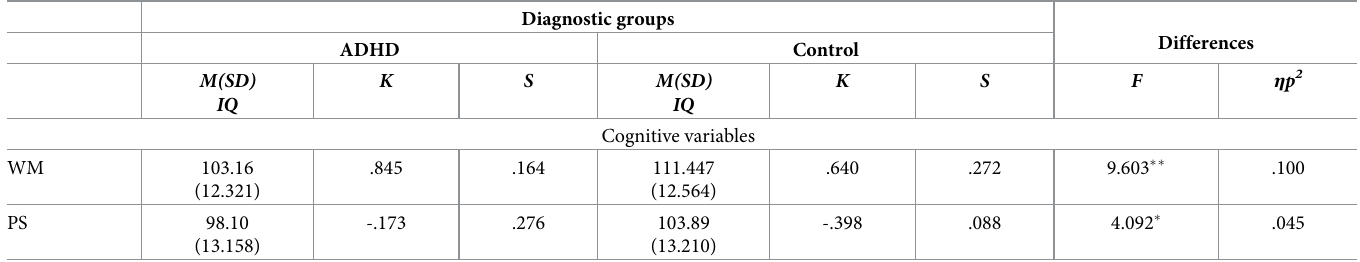
Table 2. Differences between groups and descriptive statistics for the dependent variables